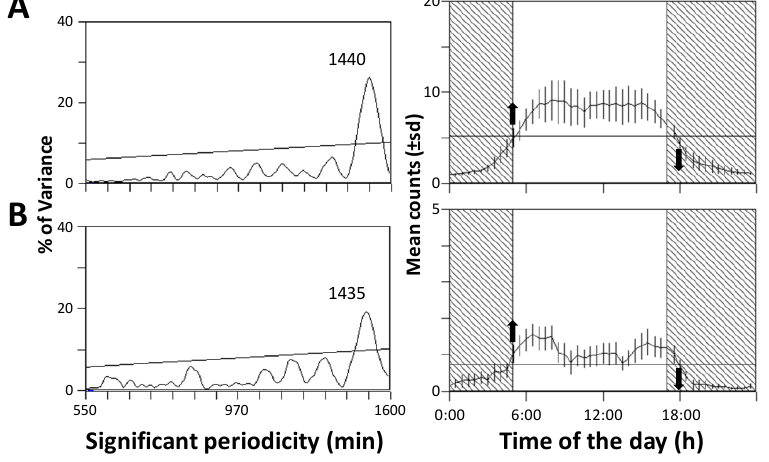
Figure 7. Periodograms (left) and waveforms (right) for visual ( A ) and automated ( B ) fish counts time series as reported at OBSEA. In waveforms plots the dashed vertical rectangle depicts the average night duration during the whole video sampling period. MESOR is the horizontal bar in waveforms (A = 5.21; B = 0.74) along with ONSET (upper arrow; the first values above MESOR) and OFFSET (lower arrow; the first value below MESOR)